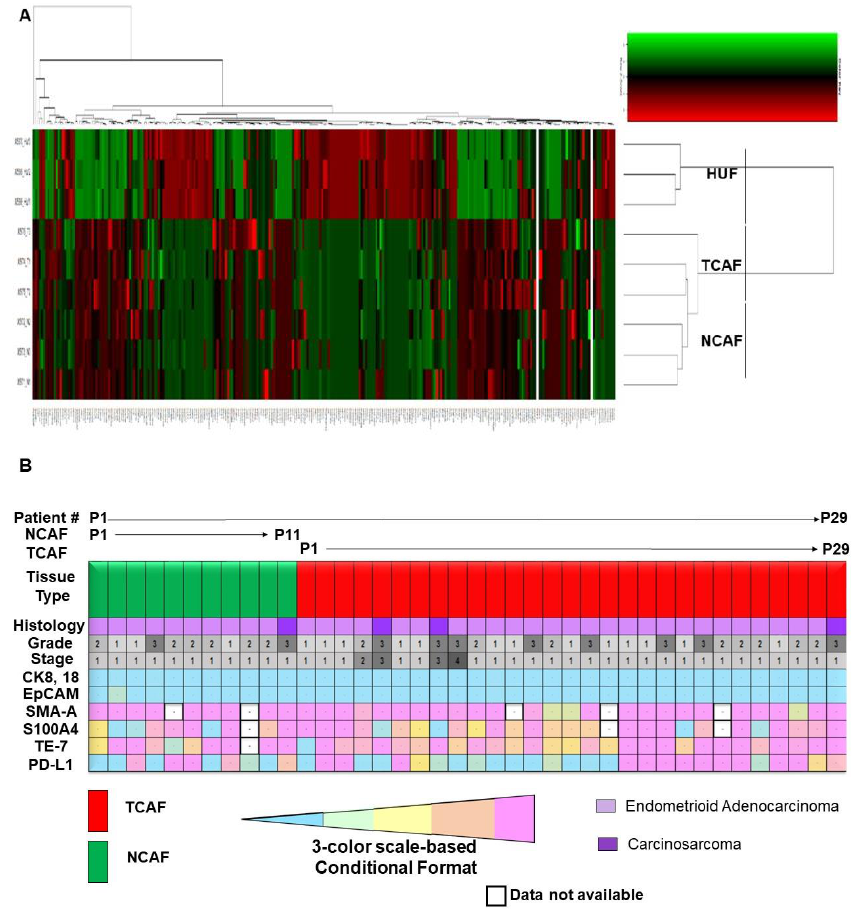
Figure 5. A comparison of NCAF with TCAF in terms of the alterations in genes and expression of protein markers: A comprehensive cancer panel report on all exon coverage on 409 genes involved in some of the most common known cancers shows the alteration of genes in aggressive TCAFs and NCAFs from the same patient compared to HUF cells ( A ). The pathway-based gene selection profiled the mutational spectrum in known cancer driver genes and drug targets along with signaling cascades, apoptosis genes, DNA repair genes, transcription regulators, inflammatory response genes, and growth factor genes. The panel covered both somatic and germline mutations. Heatmaps depicting the genetic alterations identified in NCAF, TCAF, or HUF samples are presented. The coding regions of 409 cancer-related genes are sequenced. Variants with a significant allele frequency difference between sample groups (n = 3) are summarized. Numbers of significantly altered variants of those genes are plotted. A 3-color scale-based conditionally formatted expression (% of expression by ICC) of CAF markers in aggressive TCAFs, and NCAFs from 29 representative patients sorted on the basis of CAFs with corresponding histologies, grades/stages (as presented with color codes, and numbers) is presented in a heatmap ( B ).